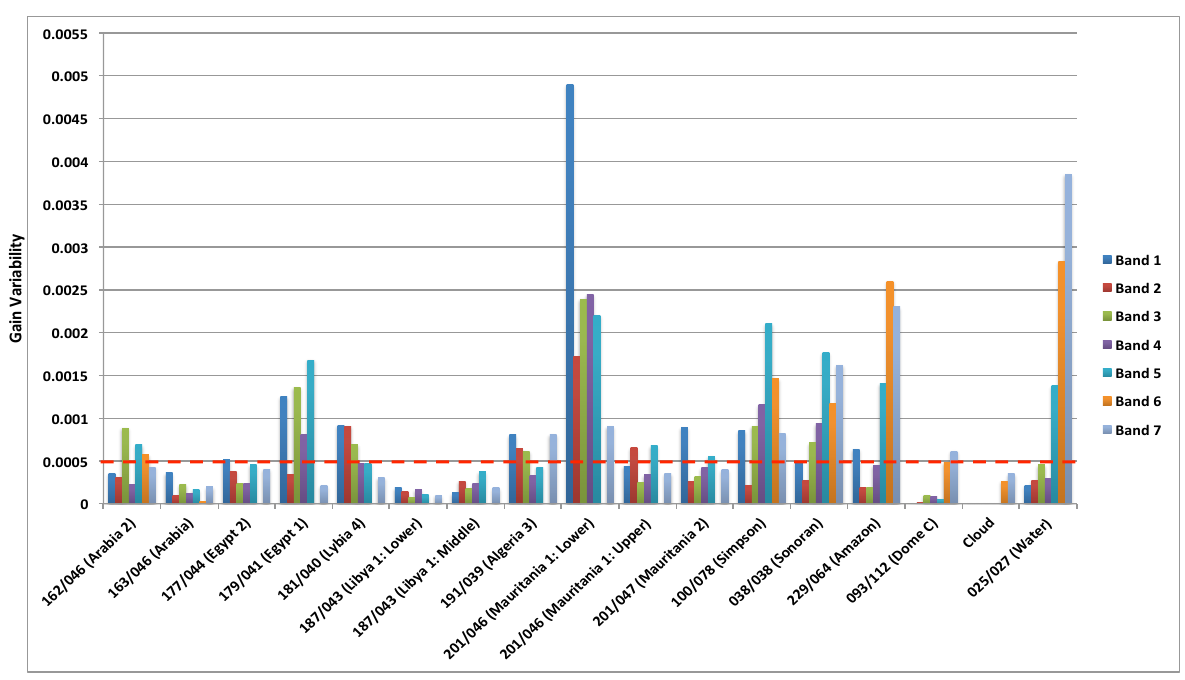
Figure 7. Within-array gain variability introduced by the sites listed in Table 1 for the first seven bands of the Operational Land Imager (OLI). The red dashed indicates the maximum acceptable target error of 0.0005 or